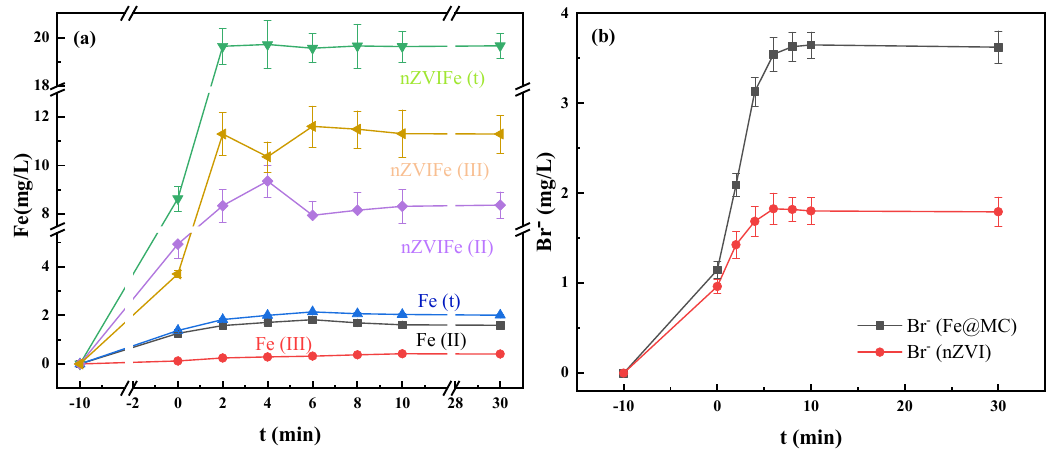
Figure 6. Concentrations of Fe(II), Fe(III) ( a ), and Br − ( b ) during the reaction.